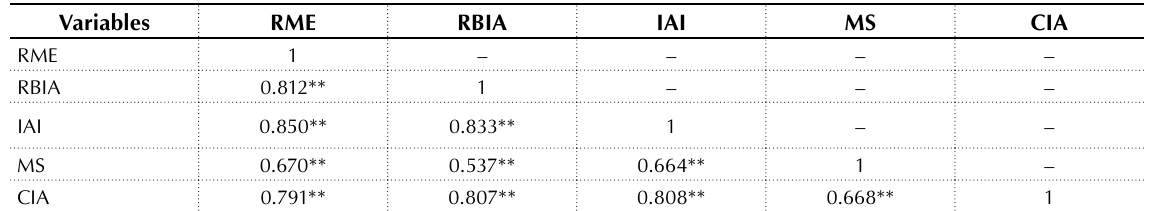
Table 3. Correlation matrix